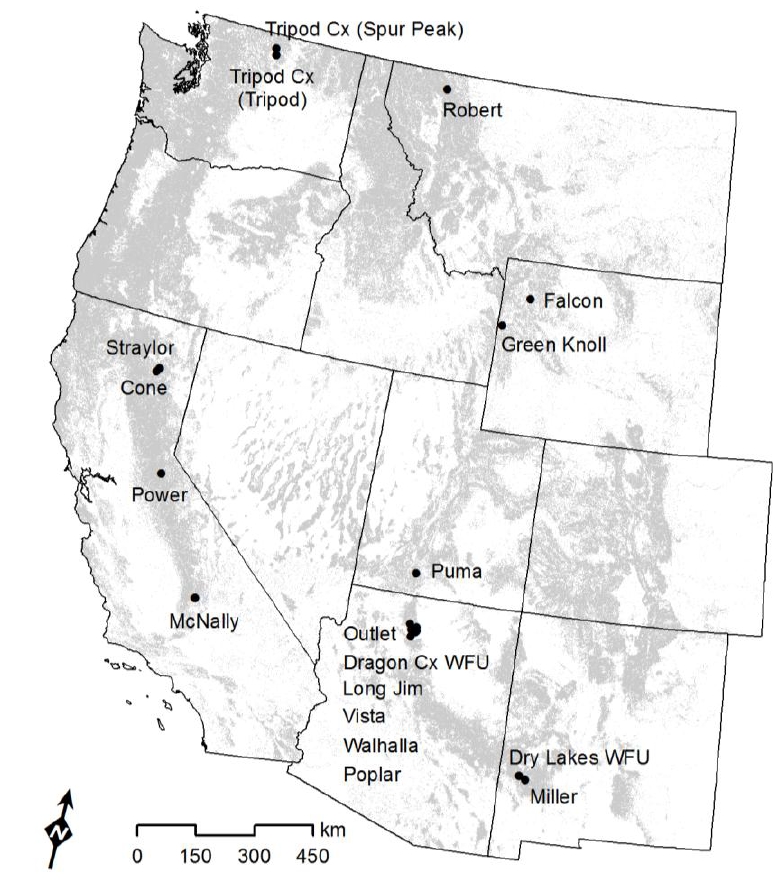
Figure 1. Location of the 18 fires included in this study. Forested areas in the western US are shown in gray